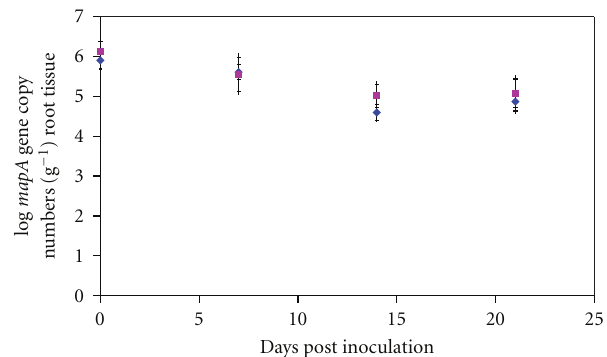
Figure 4: Comparison between the two strains of C. jejuni 6824 (blue diamonds) and 81116 (pink squares) mapA gene copy numbers detected on roots in experiment B. Error bars represent standard deviations from 5 replicate samples and 3 di ff erent real- time PCR reactions per